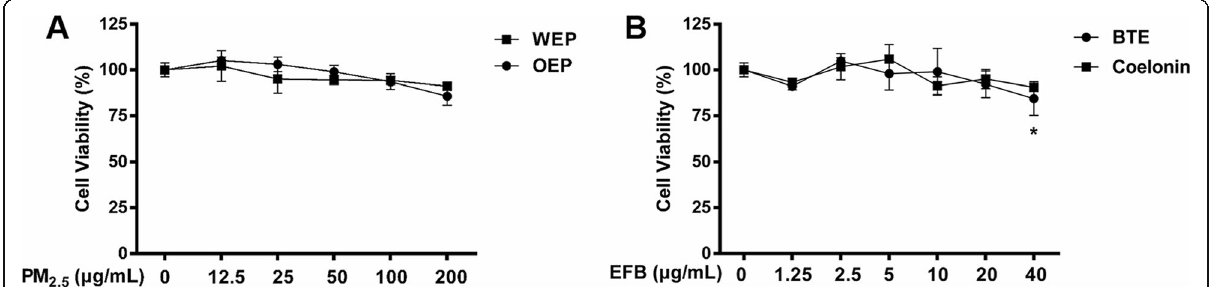
Fig. 1 Cell viability of RAW264.7 cells after exposure to PM 2.5 extracts and EFB. ( a ) Cell viability after exposure to WEP and OEP. ( b ) Cell viability after exposure to BTE and Coelonin. * < 0.05 vs.